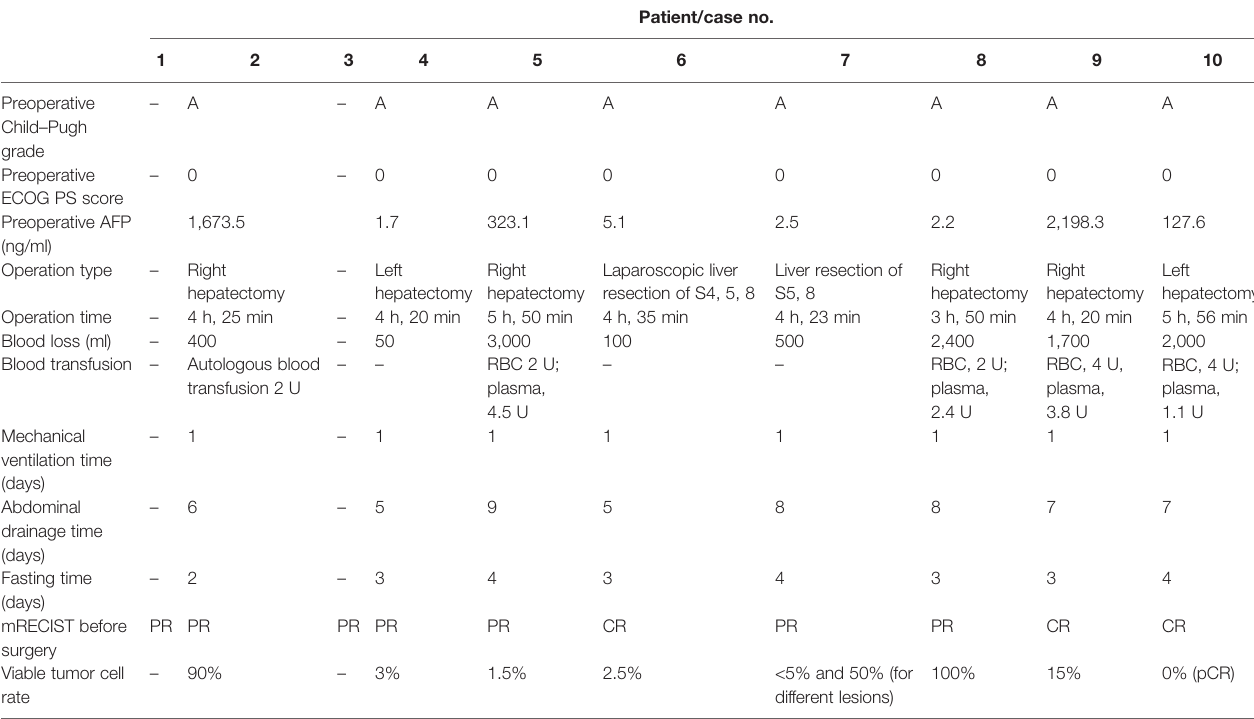
TABLE 3 | Operative and pathological